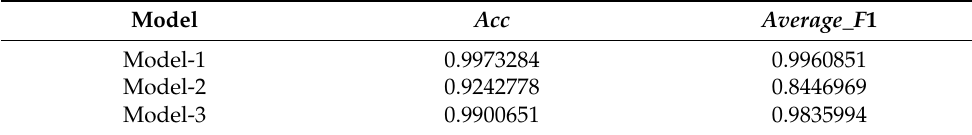
Table 3. Evaluation results of different working conditions identification